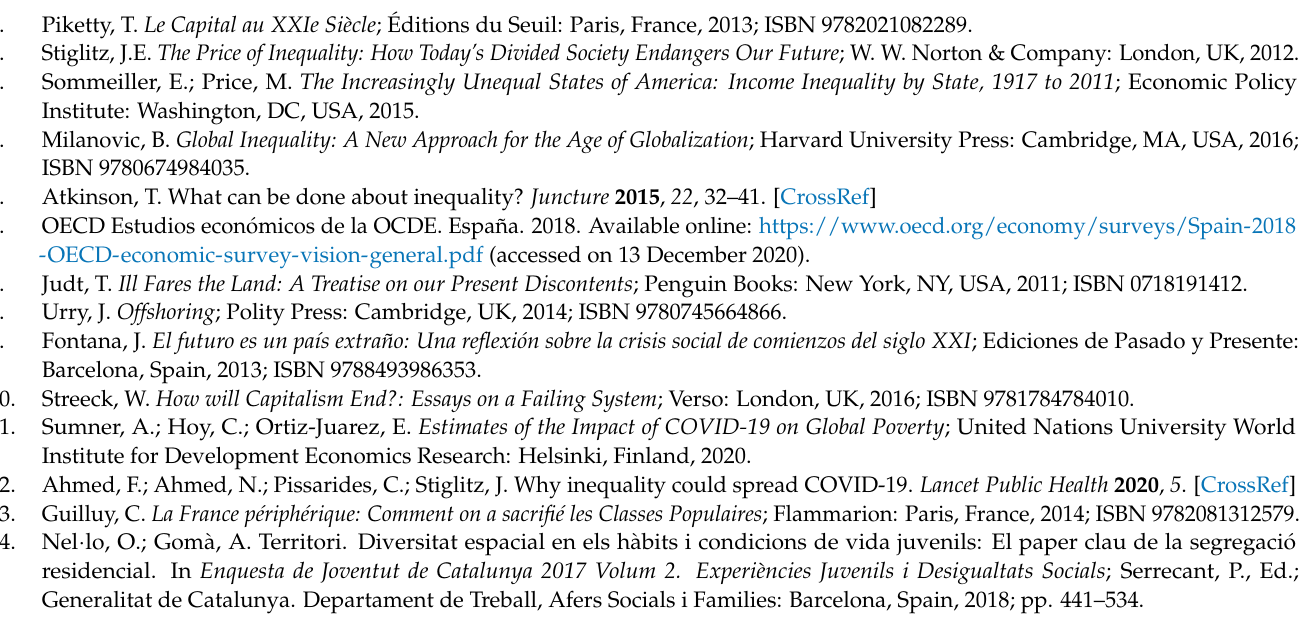
Table S2: Spearman’s correlation according to territorial aggregations, Figure S1: Percentage of population (aged 25 or over) without higher education according to Territorial settings, Catalonia, Figure S2: Percentage of population (aged 16 and over) with self-perceived health no good according to Territorial settings, Catalonia, Figure S3: Overall life satisfaction of people (aged 16 and over) according to Territorial settings, Catalonia, Figure S4: Percentage of population risk of poverty (60% median) according to Territorial settings, Catalonia, Figure S5: Percentage of population (aged 16 and over) social structure no qualified (ESEC > 3) according to Territorial settings,